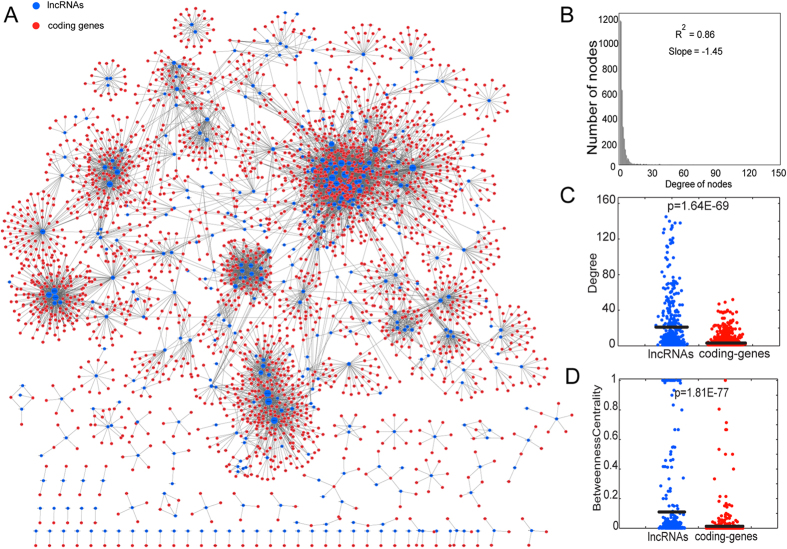
Illustrations of the OVLMN and its characteristics.(A) The OVLMN consisted of 8393 co-expression relationships between 399 lncRNAs and 2634 mRNAs. Blue circles denote lncRNAs, and red circles denote mRNAs. The node degree is indicated by the circle size. An edge represents a co-expression relationship between a lncRNA and an mRNA in the context of OV progression. (B) The degree distribution of the OVLMN is shown as an individual plot. Most of the nodes are poorly connected, and a few are relatively highly connected. The network reveals a power-law distribution with a slope of −1.46 and R2 = 0.86. (C) The LncRNA nodes have significantly higher degrees than the coding-gene nodes in the OVLMN. (D) The LncRNA nodes have significantly higher betweenness centrality than the coding-gene nodes in OVLMN.